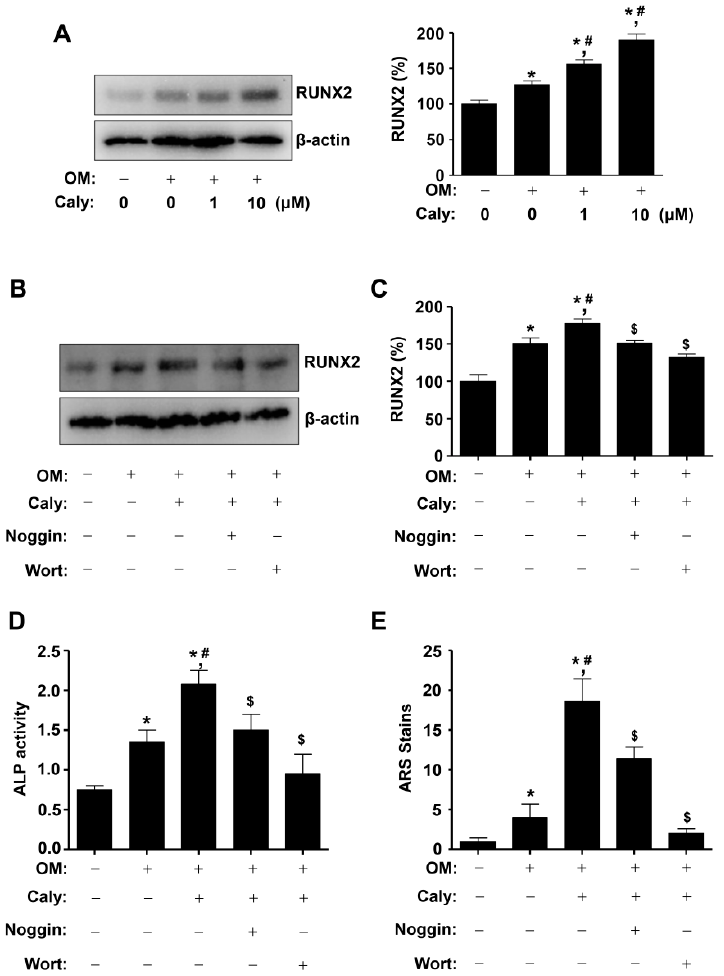
Figure 4. Caly potentiates RUNX2 expression during the osteogenesis of human MSCs. ( A ) RUNX2 and β -actin expressions were analyzed using Western blot analysis at 2 days. The bar graph shows relative RUNX2 level (%) normalized to the control (right). ( B , C ) After the pretreatment of Noggin and Wort, RUNX2 and β -actin expressions were analyzed using Western blot analysis at 2 days ( B ) The bar graph shows relative RUNX2 level (%) normalized to the control ( C ). ( D , E ) After the pretreatment of Noggin and Wort, ALP activity at 7 days ( D ) and ARS stains at 21 days ( E ) were quantitatively measured using a spectrophotometer. Data are expressed as the mean ± S.E.M. from three separate experiments (* p < 0.05 compared to the control, # p < 0.05 compared to OM, and $ p < 0.05 compared to OM +